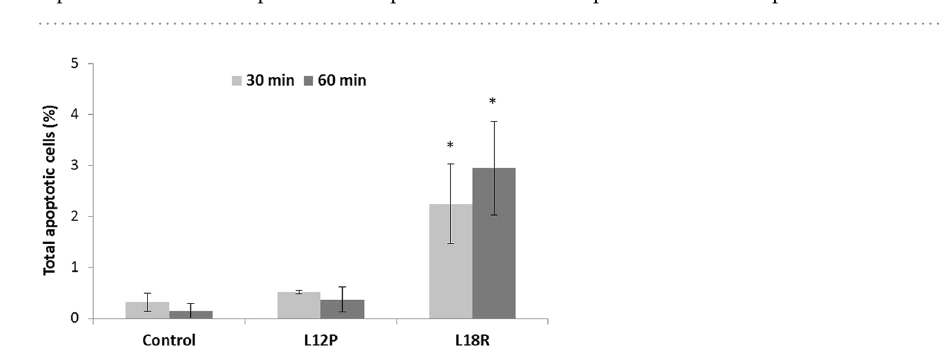
while 5/16 of the L12P-treated larvae were still alive at day 9.